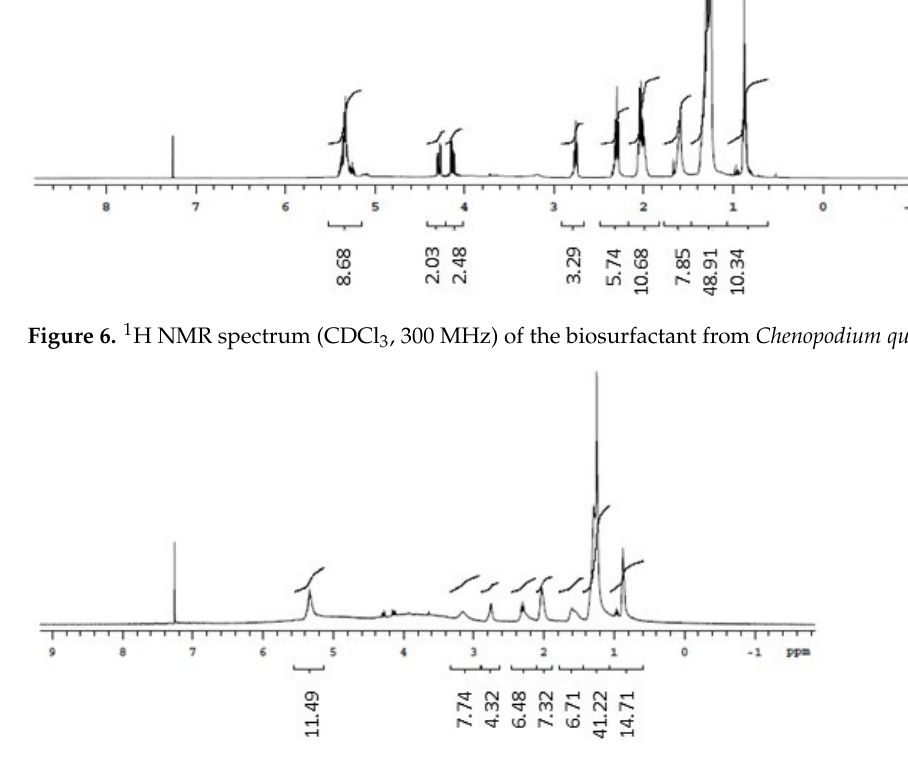
Figure 8. 1 H NMR spectrum (CDCl 3 , 300 MHz) of the biosurfactant from Malpighia emarginata. Figure 9. 1 H NMR spectrum (D 2 O, 300 MHz) of the standard saponin from Sigma. The 13 C NMR spectra revealed double bond peaks between 128 and 130 ppm for all samples, as well as methyl signals attributed to triterpene saponins both in the standard (20 ppm) and the isolated biosurfactants (20–30 ppm). Signals characteristic of oxygenated carbons were also found between 60 and 62 ppm. Peaks of aromatic carbons (152–154 ppm) were detected in both the standard and biosurfactants isolated from C. quinoa and M. emarginata (Figures S1–S4) . These results are consistent with the findings of Nasci- mento et al. [39]. No characterization of saponins from M. emarginata was found in the literature, which makes this study the first such report.